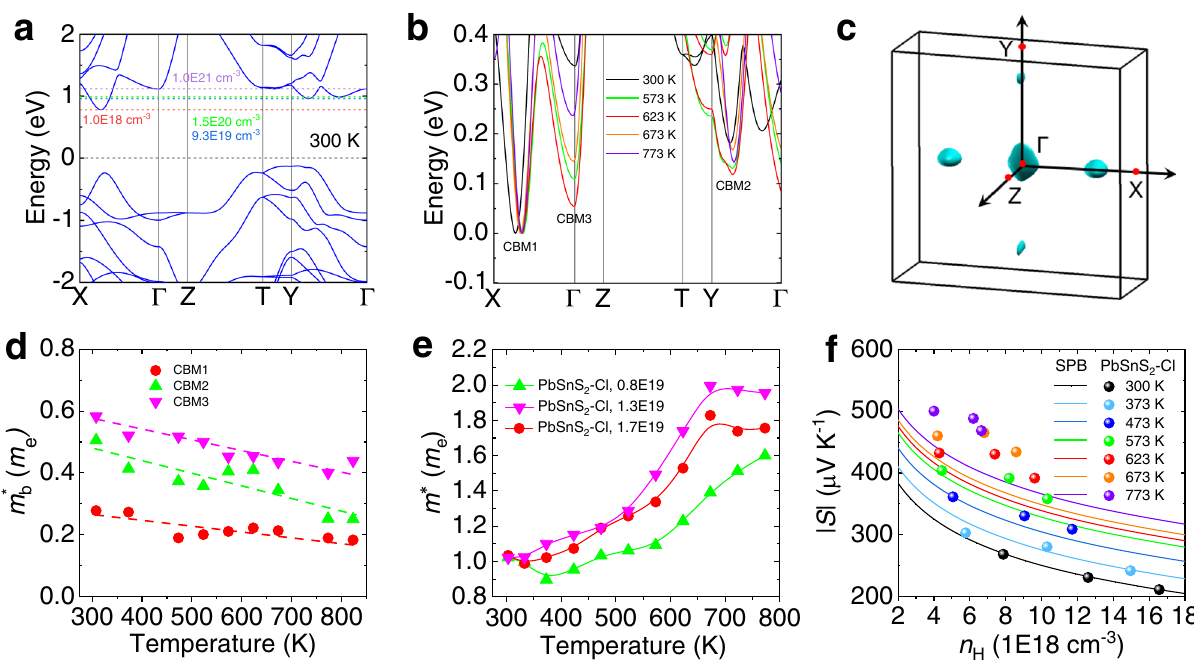
Fig. 4 | Electronic band structures of the optimal Cl doped PbSnS 2 sample. a Electronic band structure at 300K. The black dotted line represents Fermi level, and the red, blue, green, and purple dotted lines from bottom to up represent Fermi levels with carrier concentrations of 1.0×10 18 , 9.3×10 19 , 1.5×10 20 , and 1.0×10 21 cm − 3 , respectively. b The dynamic evolution of three separated bands